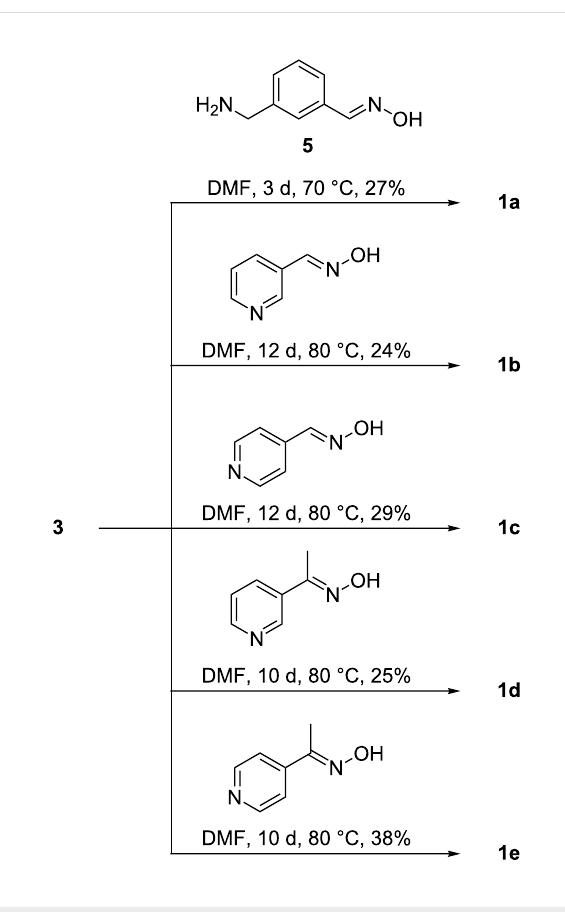
Scheme 4: Reaction conditions used for the preparation of cyclodex- trin derivatives 1a – e from tosylate 3